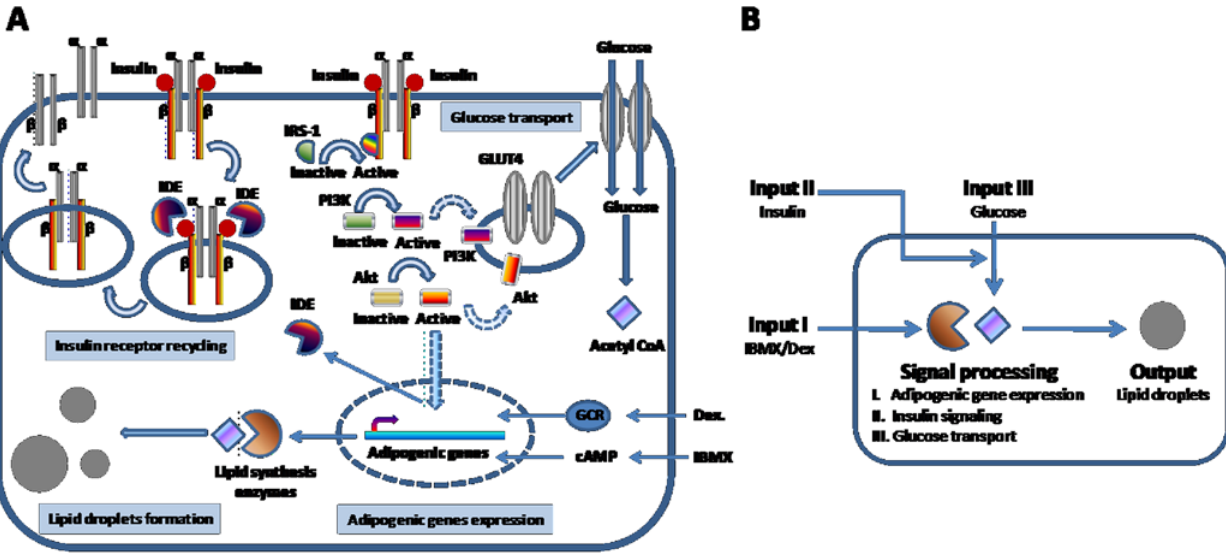
Figure 1. A simplified view of a drug-inducible adipogenesis system. ( A ) The effects of adipogenic stimulants on adipogenesis. IBMX and dexamethasone induce expression of lipid synthesis enzymes. Insulin activates kinase signaling pathway leading to glucose import. A product of glycolysis, acetyl CoA, serves as a substrate for lipid synthesis enzymes. Akt kinase activates expression of insulin degradation enzyme (IDE) which allows recycling of surface insulin receptor. ( B ) 3T3-L1 cells as single computing units. Inputs are defined as IBMX/dexamethasone, insulin, and glucose. Signal processing is defined as cellular activities induced by input signals which include adipogenic gene expression, insulin signaling, and insulin-stimulated glucose import. Output is defined as intracellular lipid droplets formation.